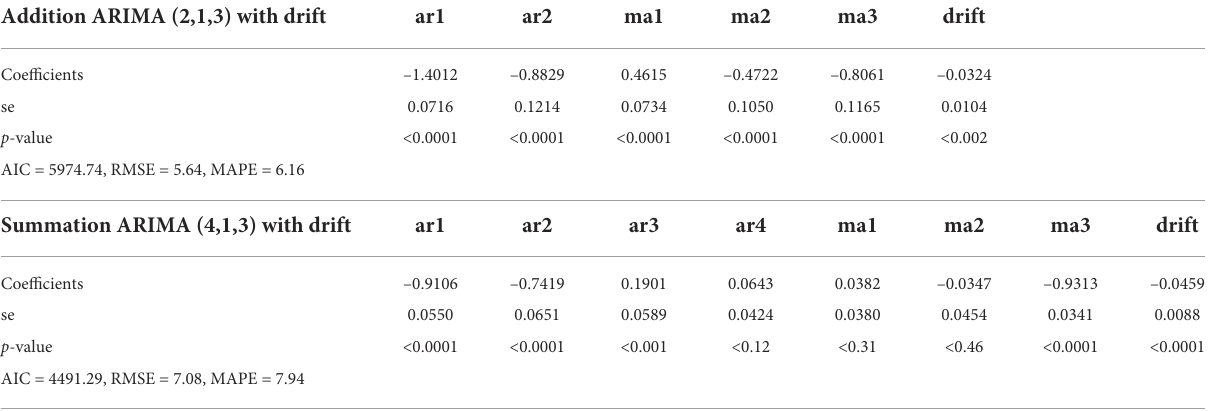
TABLE 3 Autoregressive integrated moving average model parameters for mental arithmetic addition and summation tasks during the initial study